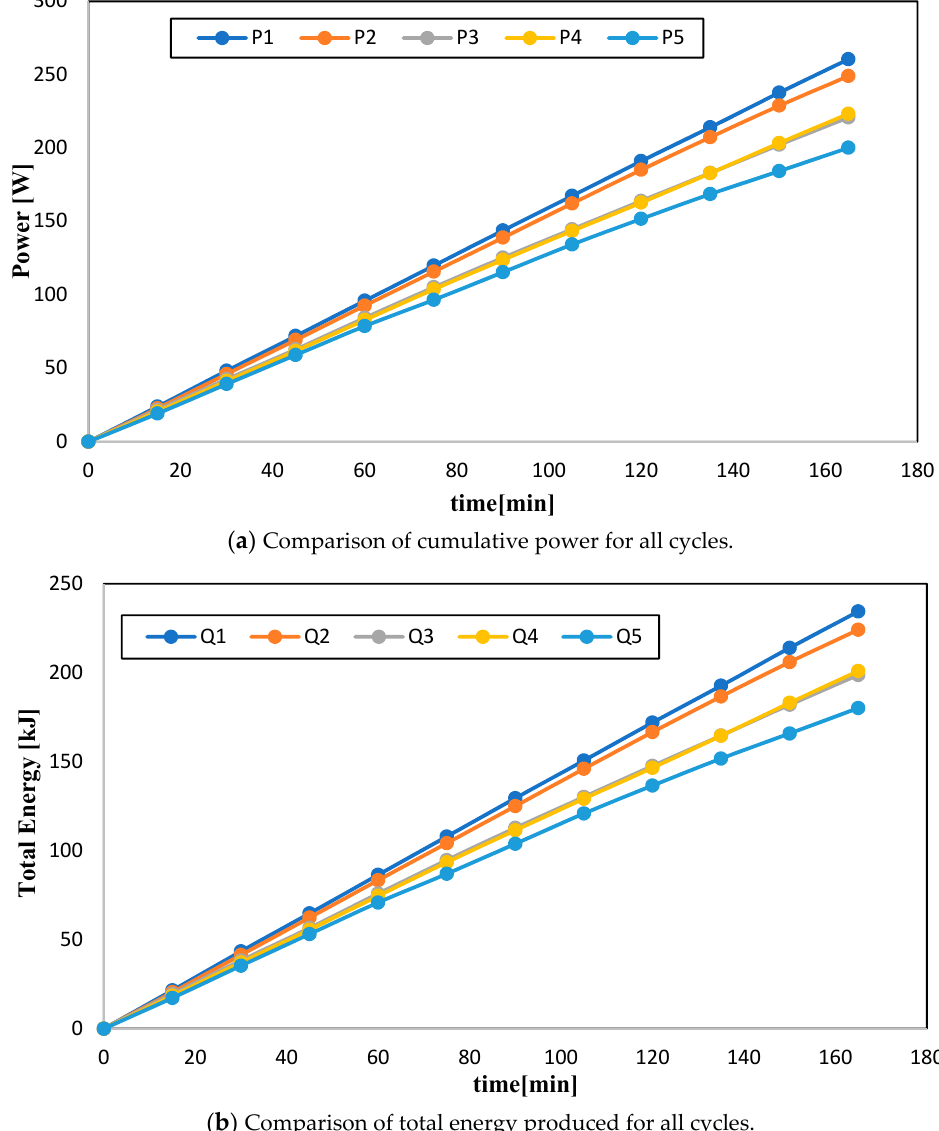
Figure 10. Comparison of cumulative power ( a ) and energy for all cycles ( b ).